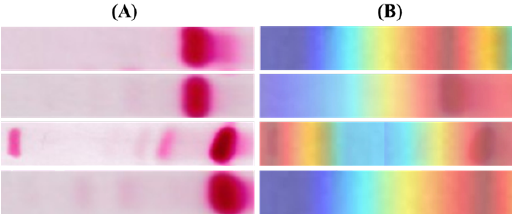
Figure 12. Score-CAM visualization of ( A ) Hb electrophoresis images, and ( B ) corresponding Score- CAM heat-map for different subjects. Table 5. Comparison of the findings of this study with those of other recent similar